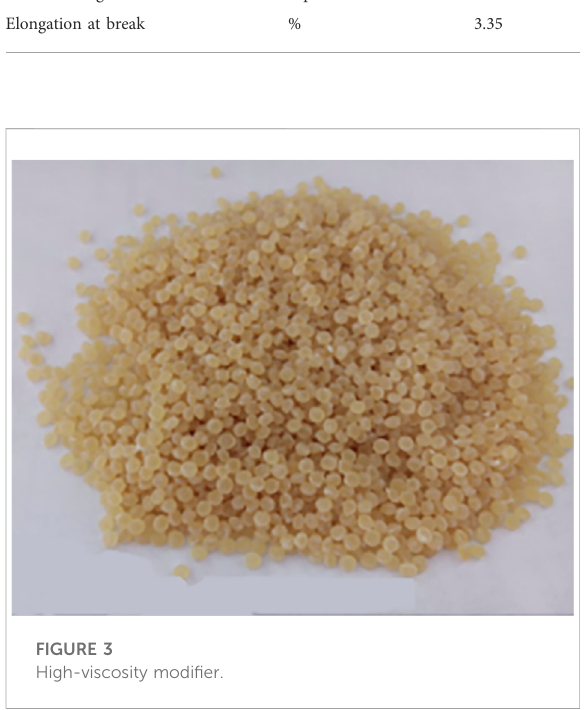
FIGURE 3 High-viscosity modi fi